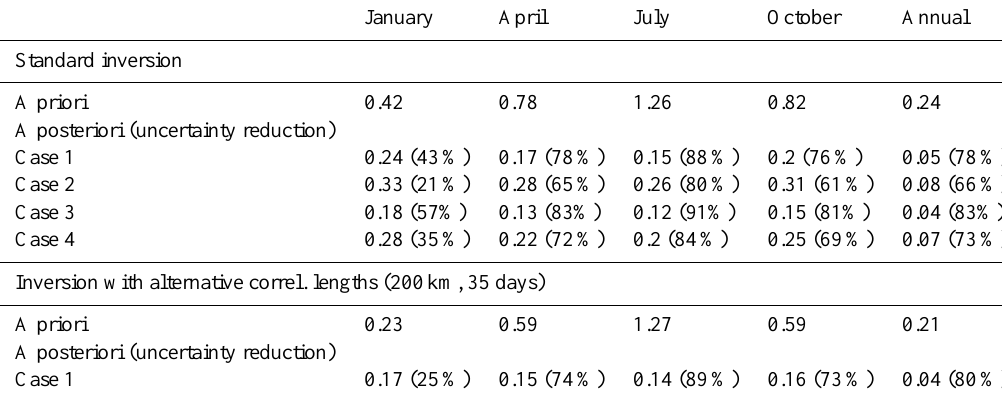
Table 2. Flux uncertainties aggregated to entire continent and month or year (PgCyr − 1 )